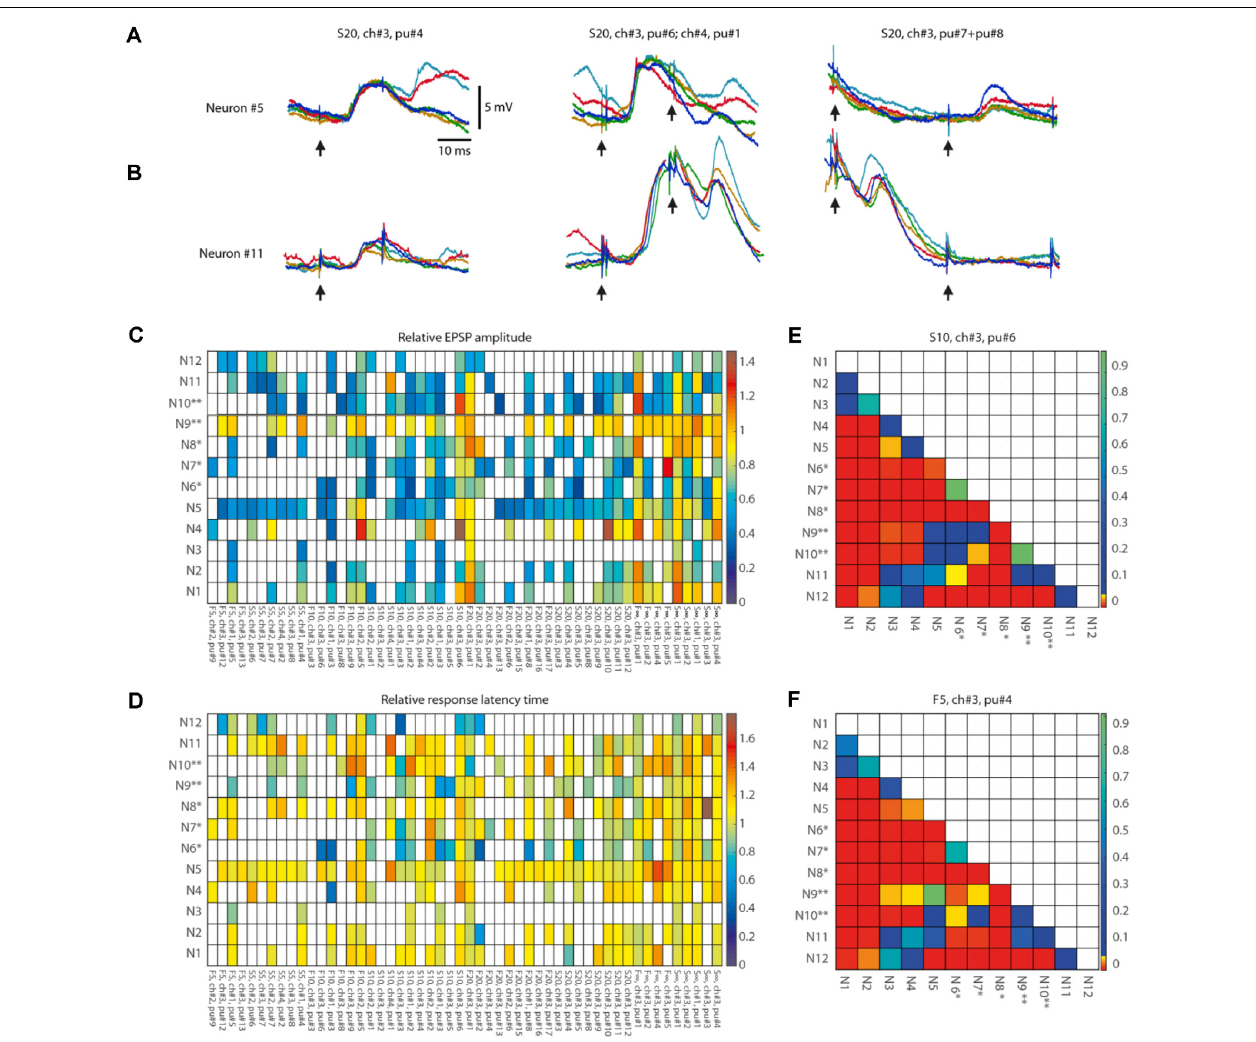
FIGURE 7 | Response metrics differences between neurons for isolated within-pattern stimulation pulses. (A,B) Examples of the variation of the responses to single-pulse stimulation of the same channel depending on the pulse position within the stimulation pattern and the neuron (shown for Neuron#5 and Neuron#11). Five superimposed raw data traces are shown for each neuron for the responses to stimulation of ch#3 at various time points (as indicated by pu# and arrows below traces) within stimulation pattern S20. (C) Average EPSP amplitude, indicated as multiples of the average EPSP amplitude to the isolated single-pulse stimulation of the corresponding channel in the same neuron ( Figure 6 ), shown for each neuron and each analyzed within-pattern stimulation pulse ( N = 52), corresponding to a total of 56,762 responses. For each analyzed stimulation pulse, the stimulus pattern and the sequential position of the pulse within that pattern (pu#) for each respective stimulation channel (ch#) are indicated at the bottom (organized according to their order of occurrence within the stimulation patterns). White entries indicate that the response fraction did not surpass the spontaneous level of EPSP events by more than two standard deviations according to the automatic EPSP detection method and the response was hence discarded from further analysis. (D) Similar display as in (A) , but for the relative response latency time, i.e., the latency expressed as multiples of the average response latency time to isolated single-pulse stimulation of the corresponding channel. (E,F) Pairwise comparisons of differences in EPSP amplitudes between all neurons. For two sample stimulation pulse positions (S10, ch#3, pu#6; and F5, ch#3, pu#4, respectively) we analyzed whether the changes in relative EPSP amplitude (compared to the neuron’s isolated single-pulse response) differed between neurons. The p -values of the Wilcoxon rank sum test for each pairwise comparison of the raw EPSP-like responses are reported as a color code in the matrix ( N = 56